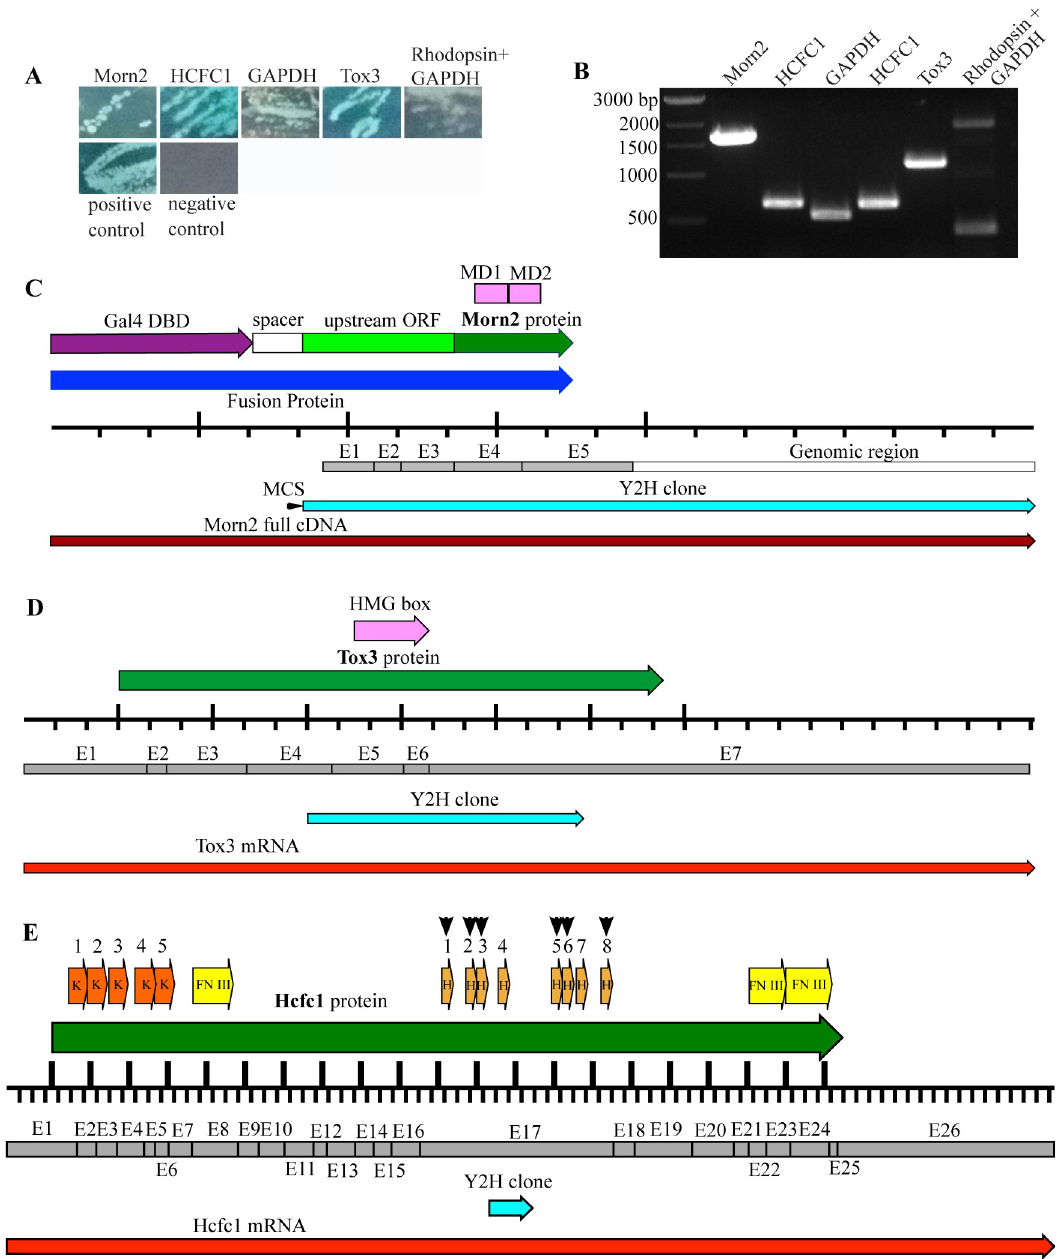
Fig 3. Yeast 2 hybrid analysis shows 5 proteins interacting with Cpne4 vWAdomain. (A)A Gal4 based yeast two hybrid analysis on the adult mouse retina cDNA library with Cpne4 vWA domain as bait protein showed five positive interactions (blue colonies). (B) Gel image of colony PCR performed on the positive clones from the yeast two hybrid shows the corresponding interacting DNA sequences. The identity of these DNA sequences as confirmed by the Sanger sequencing followed by BLAST analysis are shown as labels on the lanes. (C-E) Sequence maps of the interacting peptides as identified by Sanger sequencing followed by BLAST analysis are shown for- Morn2 (C), Tox3 (D) and HCFC1 (E). The relative positions of the actual interacting region ( light blue ) are indicated on the respective protein ( dark green ) and the corresponding mRNA ( red ) or prey Gal4 DBD- cDNA ( maroon ) sequences, and the exons ( gray ) are also indicated on the respective maps.The black ruler with tick marks indicates 100 amino acids (upward ticks) or 100 base pairs (downward ticks).The various domains and regions are as labeled on the maps. E: Exon; MD: Morn domain; MCS: Multi cloning site; K: Kelch domain; FN III: Fibronectin type III domain; H: Cleavage site, Gal4 DBD: Gal4 DNA binding domain derived from prey